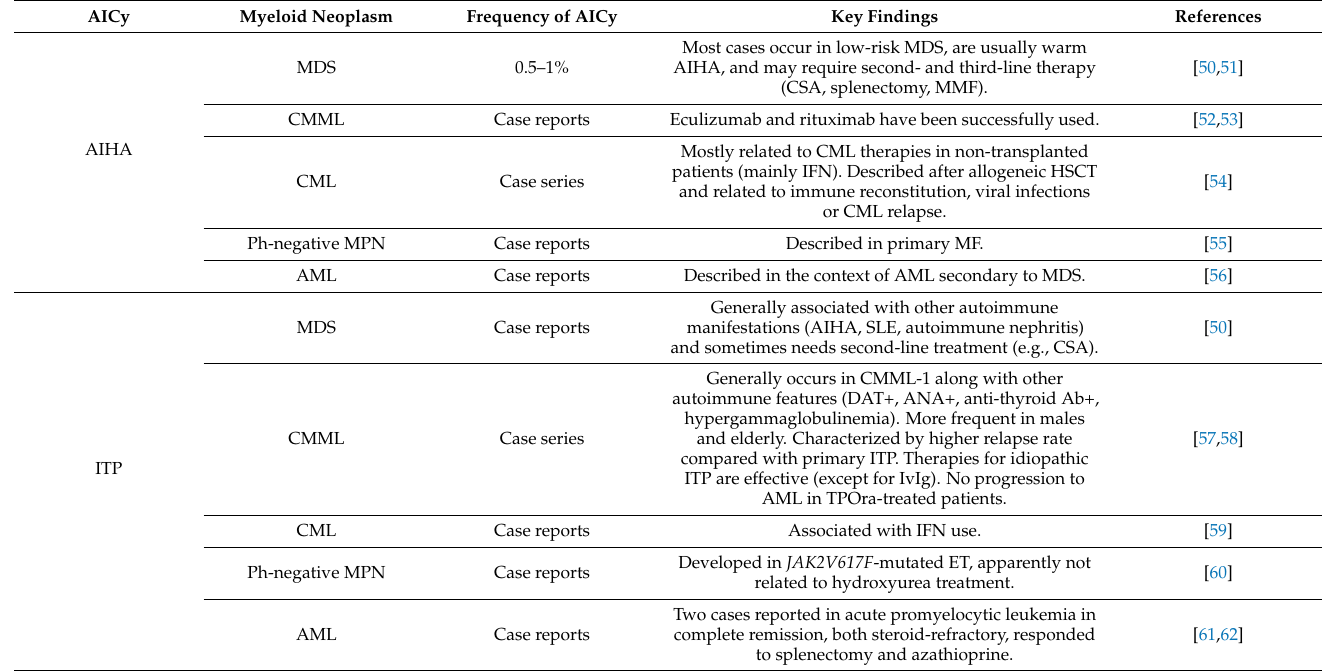
Table 3. Autoimmune cytopenias (AICy) complicating myeloid neoplasms. AICy Myeloid Neoplasm Frequency of AICy Key